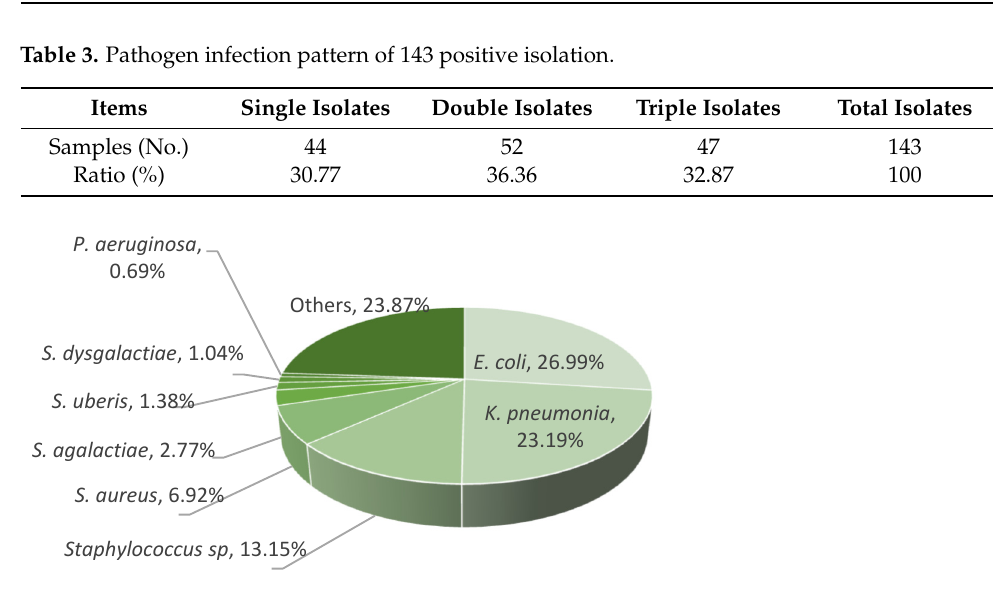
Figure 1. Analysis of 289 strains of pathogenic bacteria of bovine mastitis. All isolates were obtained and identified through bacterial isolation, purification, and 16S rDNA identification.